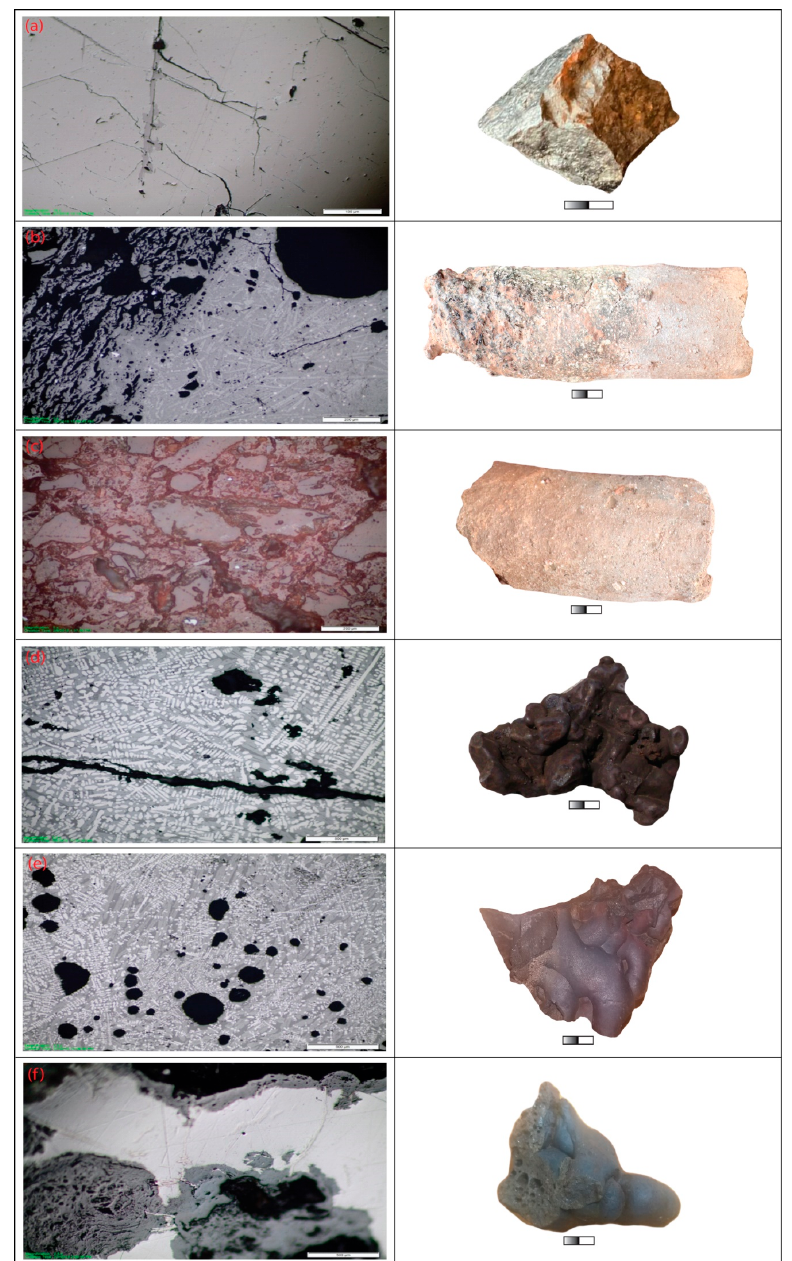
Figure 3. Photographs, and photomicrographs of ( a ) Mut2/98/ore 02 (partially heated ore) specimen showing iron oxide with thermal cracks and little to no gangue minerals; ( b ) Mut2/98/Tuyere/011/02 specimen showing contact between the melting ceramic and the slag. The melting ceramic is porous with occasional bright white metal droplets while the slag is dominated by skeletal crystals of fayalite in a glass matrix; ( c ) Mutoti 2/98/Tuyere/011/ showing quartz crystals and porosity in a clay matrix; ( d ) Mutoti 2/98/Slag/013/02 slag sample showing elongated fayalite, porosity and dendrites of wüstite embedded in a matrix of glass; ( e ) Mutoti 2/98/Slag/009/01 slag specimen showing the abundance of wüstite dendrites, porosity, dark glass, and fayalite crystals; and ( f ) Mut2/98/ Slag/001/01 bloom specimen showing metallic iron surrounded by corrosion